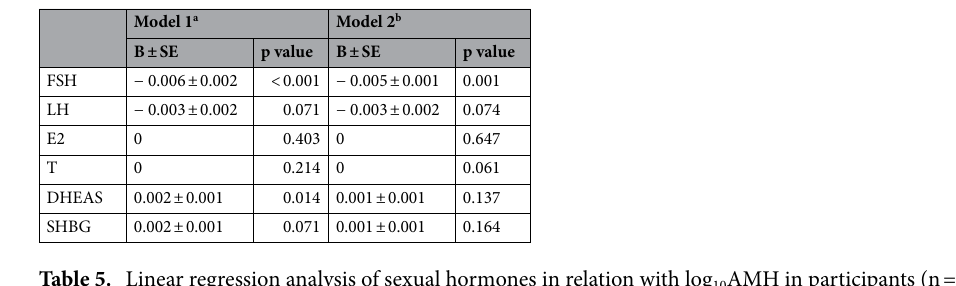
Table 5. Linear regression analysis of sexual hormones in relation with log 10 AMH in participants (n = 177). a Model 1—adjusted for SRA. b Model 2—adjusted for SRA and